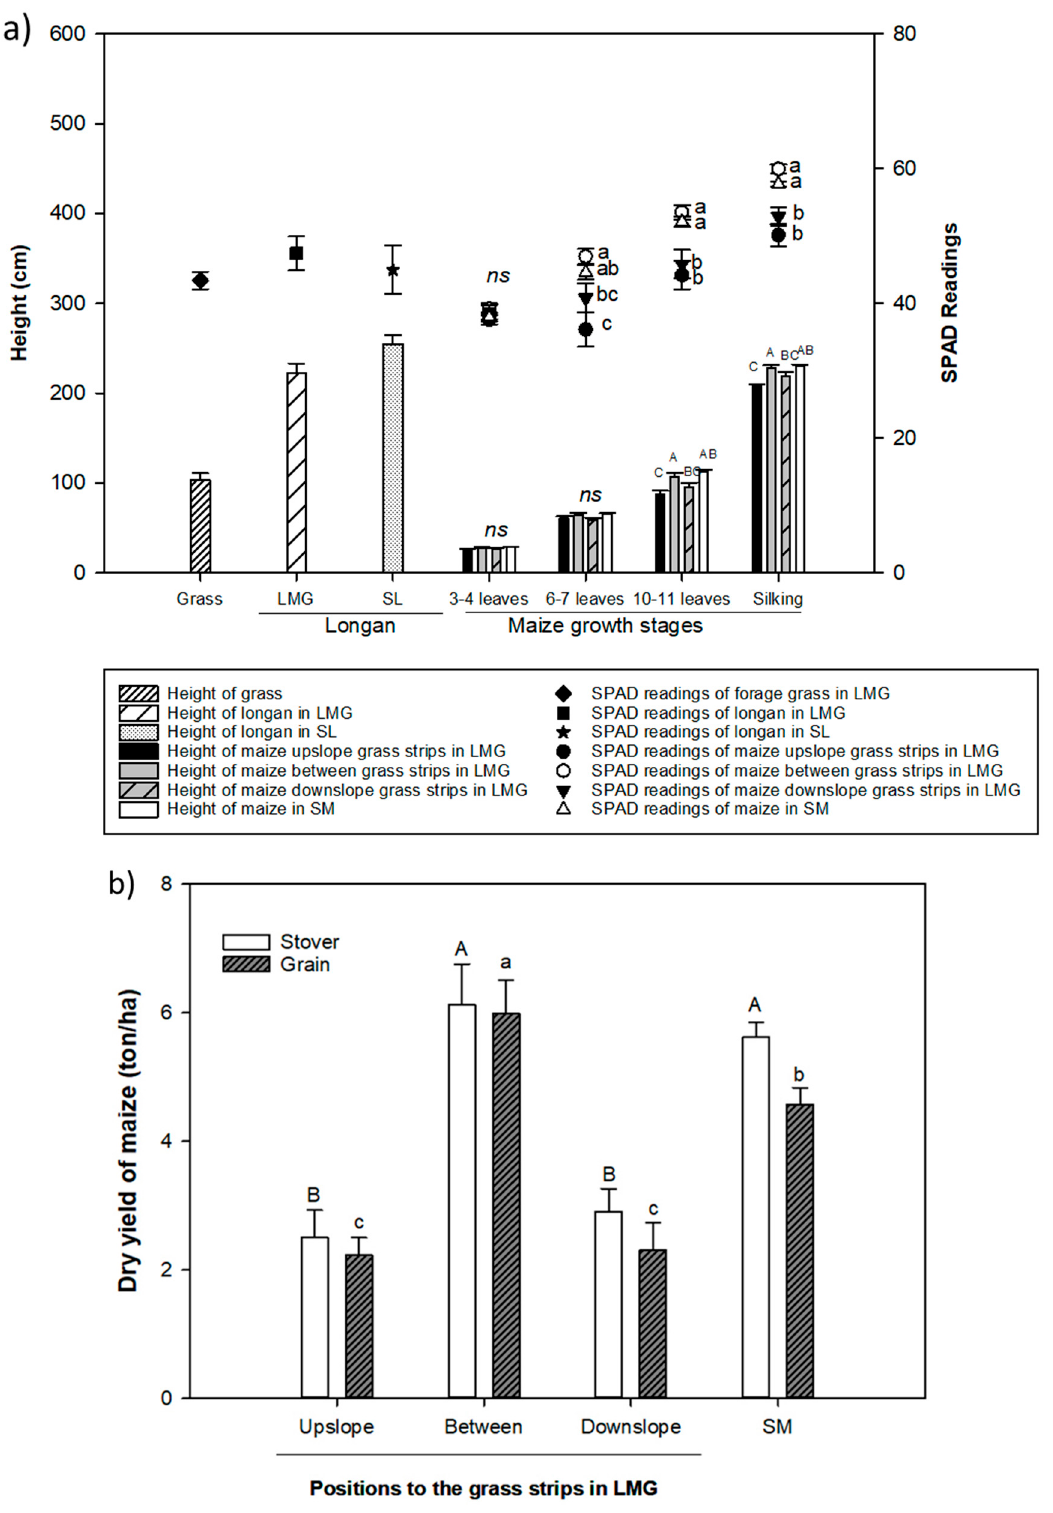
Figure 5. ( a ) Height of the tree and crop components and SPAD (soil plant analysis development) readings in the longan–maize–forage grass (LMG), sole-longan (SL) and sole-maize (SM); ( b ) dry yield of maize growing in different positions (upslope, between, downslope) relative to the grass strips within LMG in year 7. Values are means and standard errors. Bars with different upper case (stover) and lower-case (grain) letters indicate significant differences ( p < 0.05).